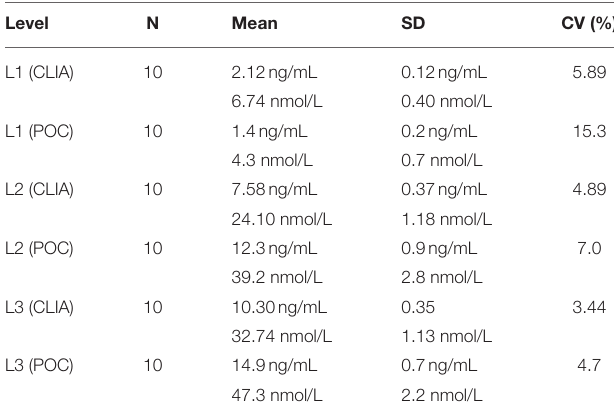
TABLE 4 | Intra-assay coefficients of variation (CVs) at low (L1), intermediate (L2), and high (L3) concentrations of canine serum progesterone for a point-of-care analyzer (POC) and reference chemiluminescent assay